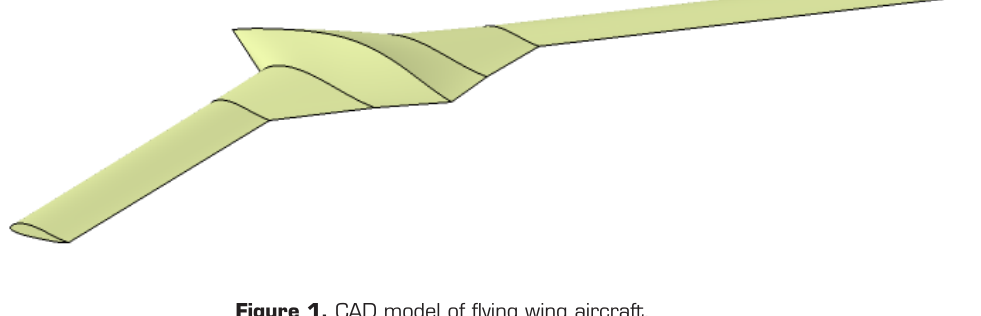
Figure 1. CAD model of flying wing aircraft.